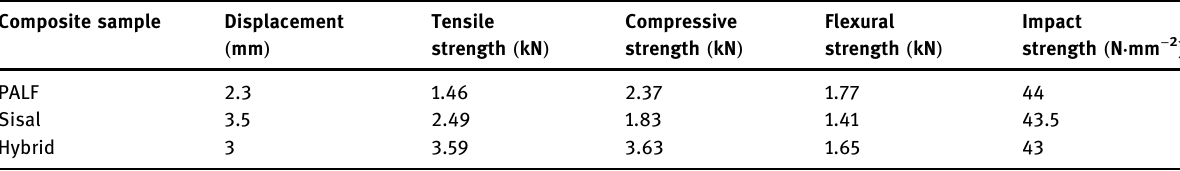
Table 1: Mechanical properties of the composites Composite